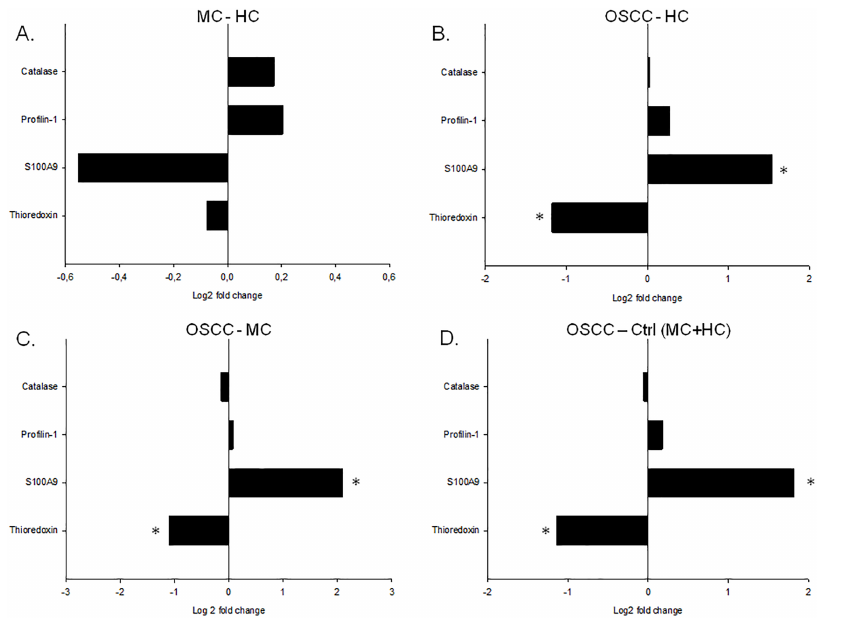
Fig 3. Quantitative analysis of salivaryproteins by SRM. The log2 fold changein case of thioredoxin, S100A9, profilinand catalaseis shown. The comparisonbetweenthe (A) age matched controls (MC) and healthycontrols (HC), (B) OSCC group and healthycontrol (HC) group, (C) OSCC group and age matched (MC) group and (D) OSCC group and both healthyand matched control groups is indicated. * indicates significantchange,p < 0.05.